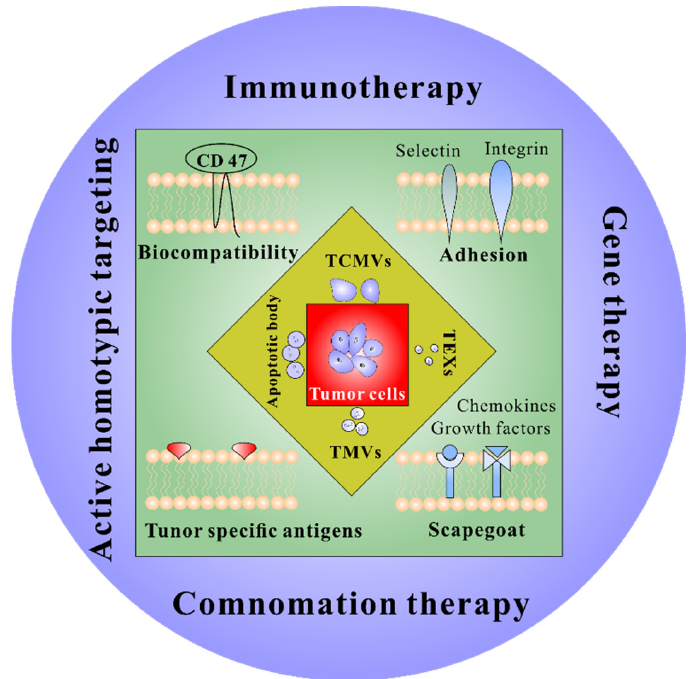
Figure 1. Properties and application prospects of TDMVs. TCMVs, tumor-derived cell membrane vesicles; TEXs, tumor-derived exosomes; TMVs, tumor-derived microvesicles.